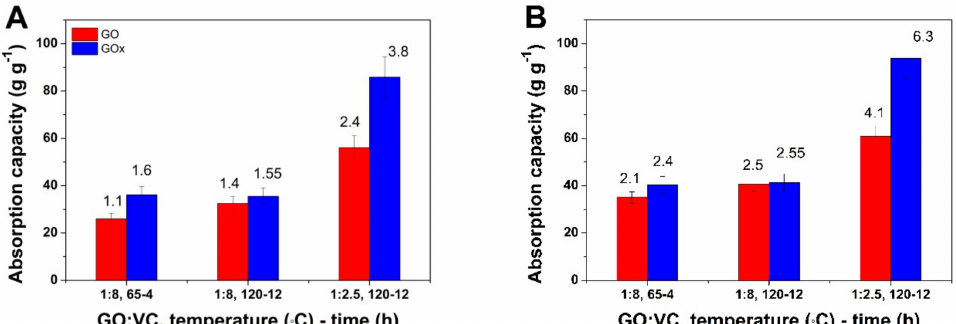
Figure 5. Adsorption capacity evolution and the absorption rate (g s − 1 , values indicated in the plot) for GO and GOx aerogels for oil / water ( A ) and organic solvent ( B )